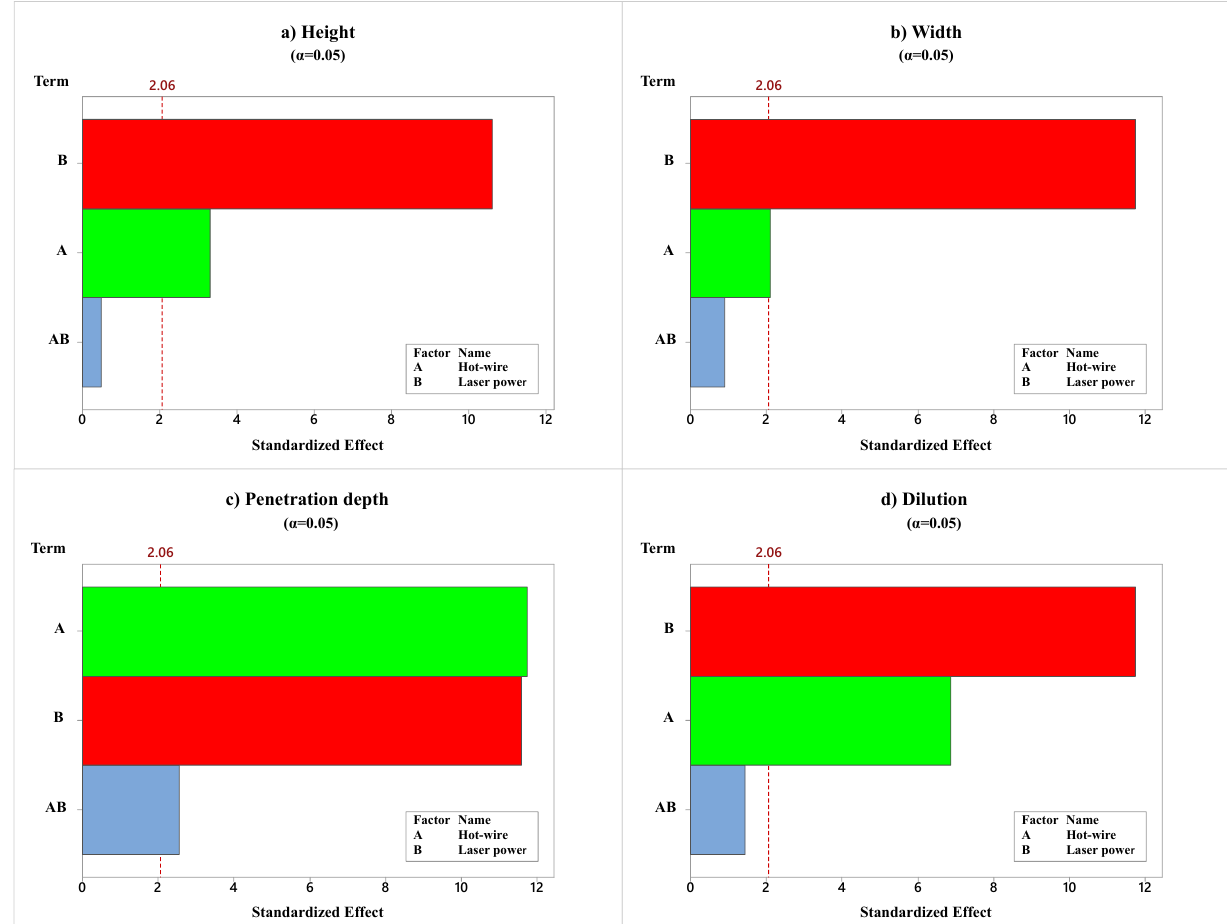
Figure 10. The standardized effects of the laser power and the hot-wire (level L0-L3) on the geometric features: ( a ) height, ( b ) width, ( c ) penetration depth, ( d ) dilution. The threshold value of statistical relevance for this analyzes was equal to 2.06 according to the 95% confidence level and the t-student